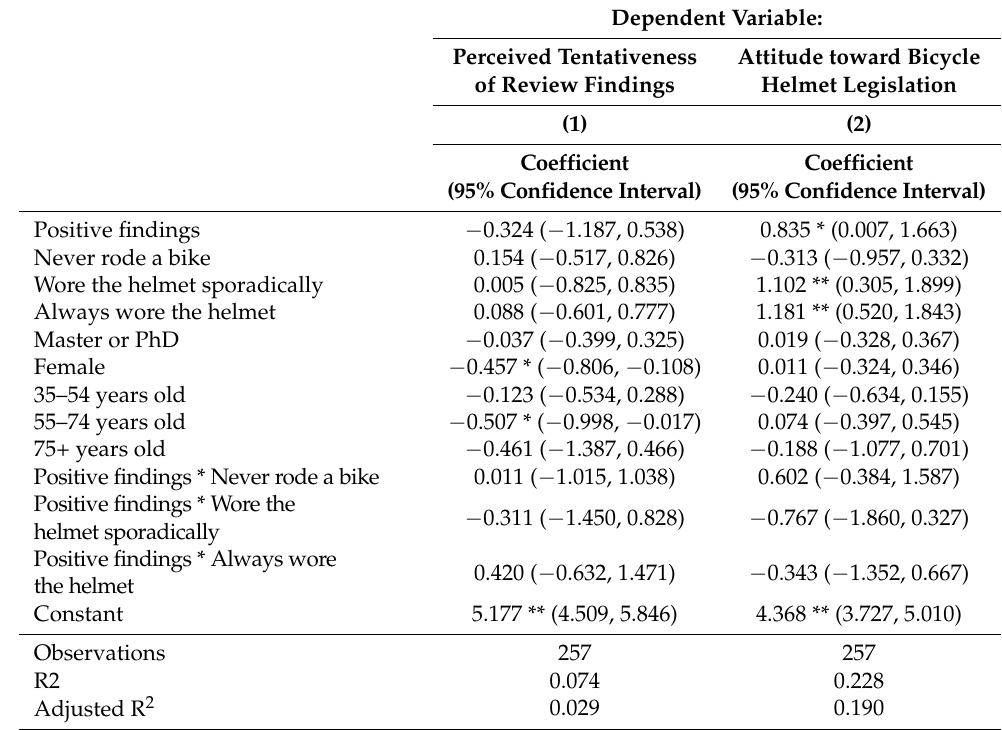
Table 5. OLS regression results for the fourth set of research